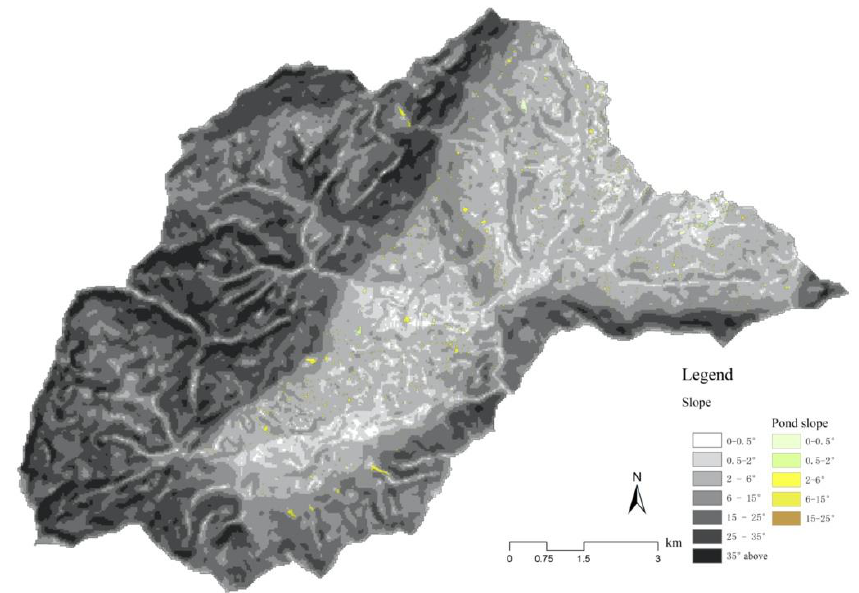
Figure 8. The slope for the Beitang landscape.